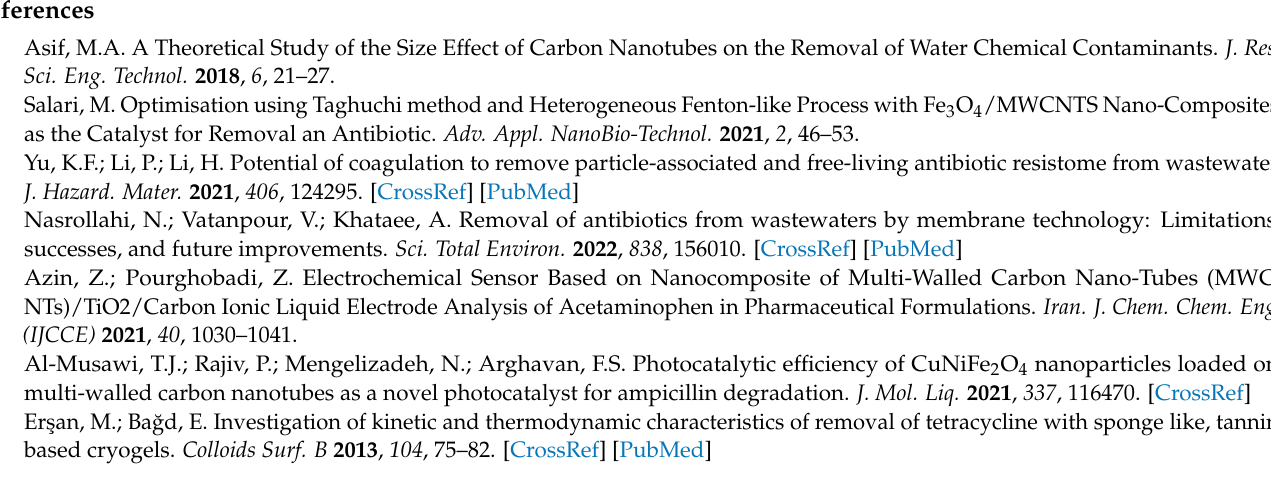
Table S3: Non-linear forms of isotherms